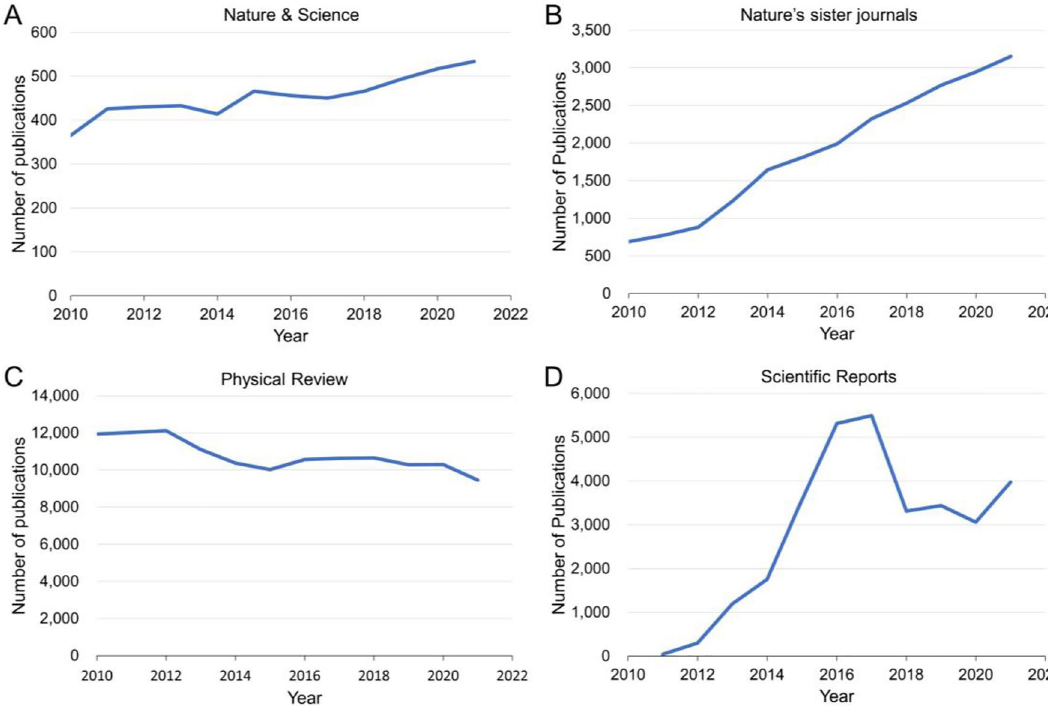
Figure 1. Annual publications of ( A ) Nature and Science, ( B ) Nature’s sister journals, ( C ) Physical Review family (Physical Review A, B, Letters, and X), and ( D ) Scientific Reports from 2010 to 2021. The average annual growth ( G 0 ) is 0.025, 0.128, − 0.02, and 0.108,